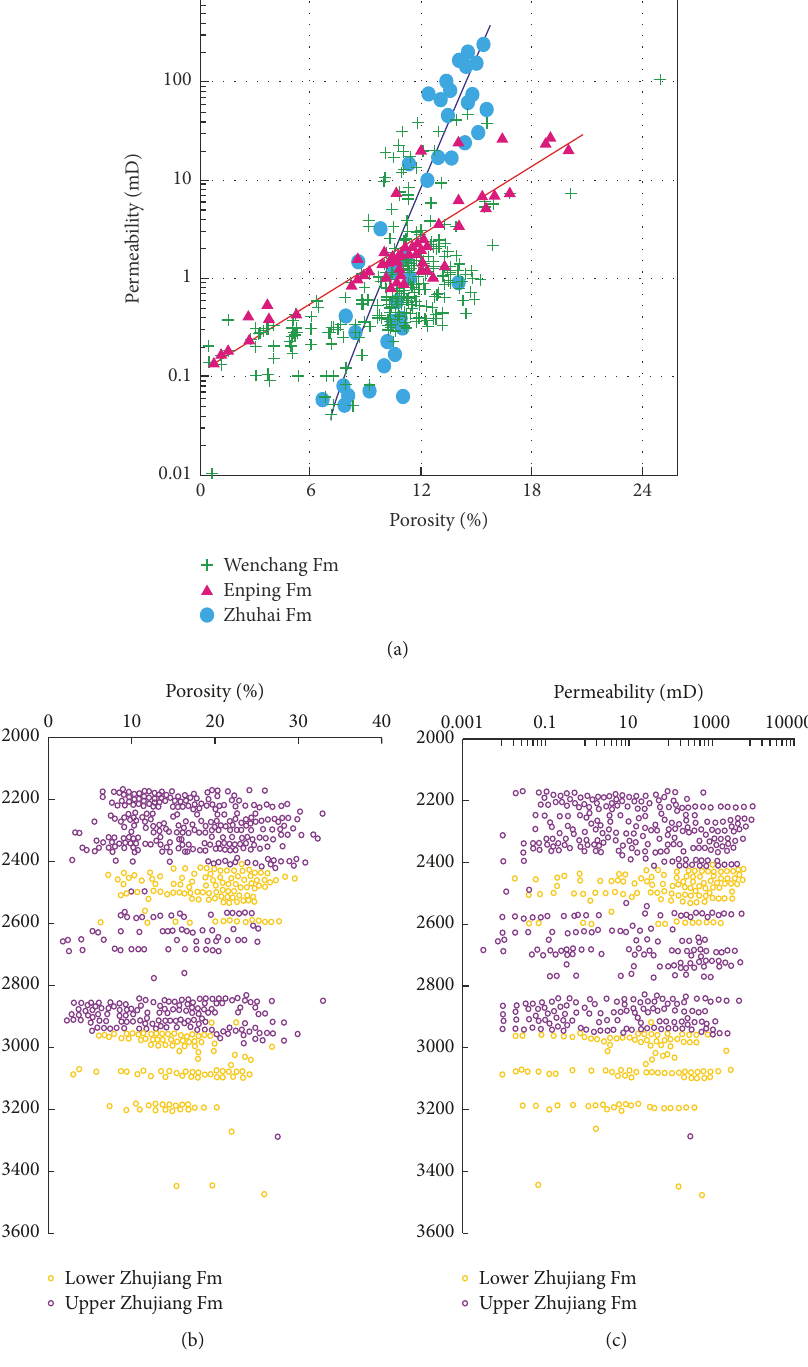
Figure 11: Porosity and permeability of the Paleogene (a) and Miocene (b, c) reservoir in the Huizhou Sag (physical properties of the Cenozoic reservoir modified after Peng et al. [3,